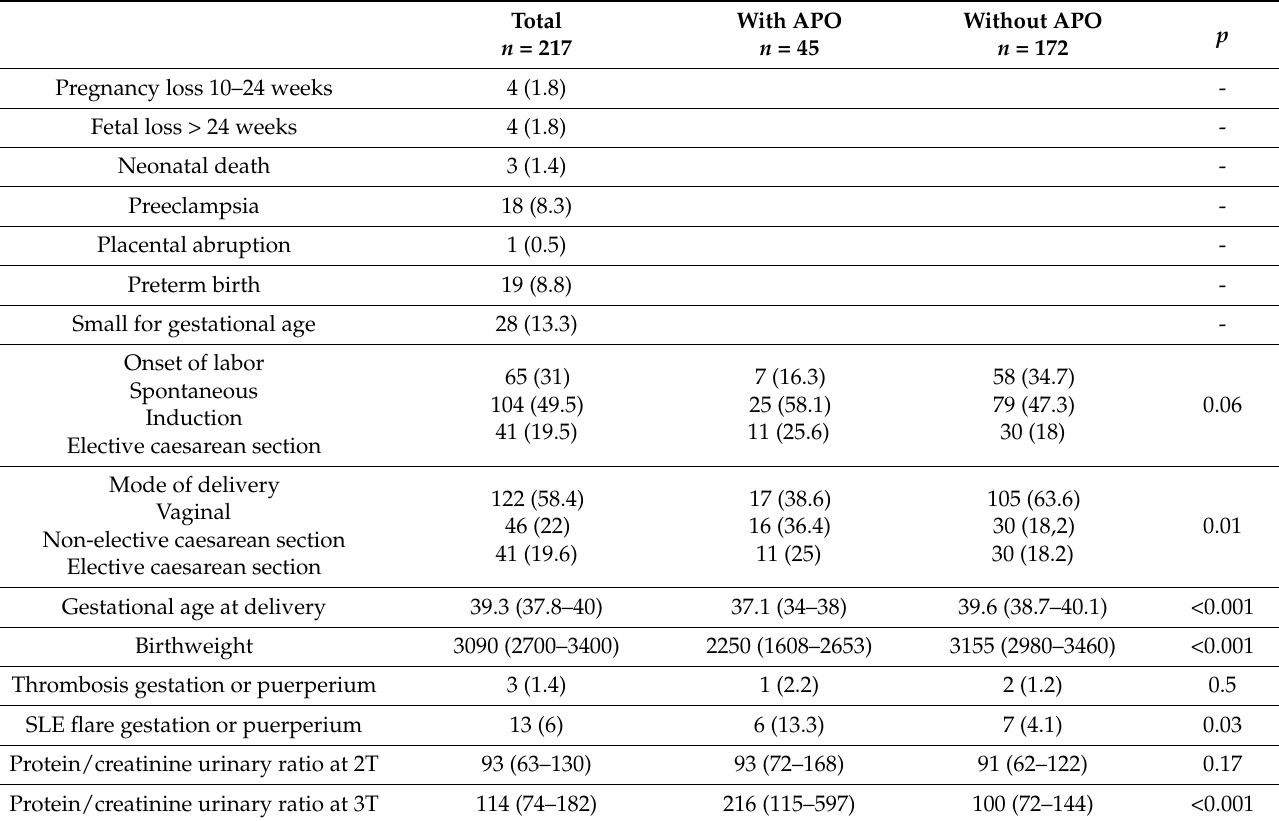
Table 3. Obstetric follow-up and pregnancy